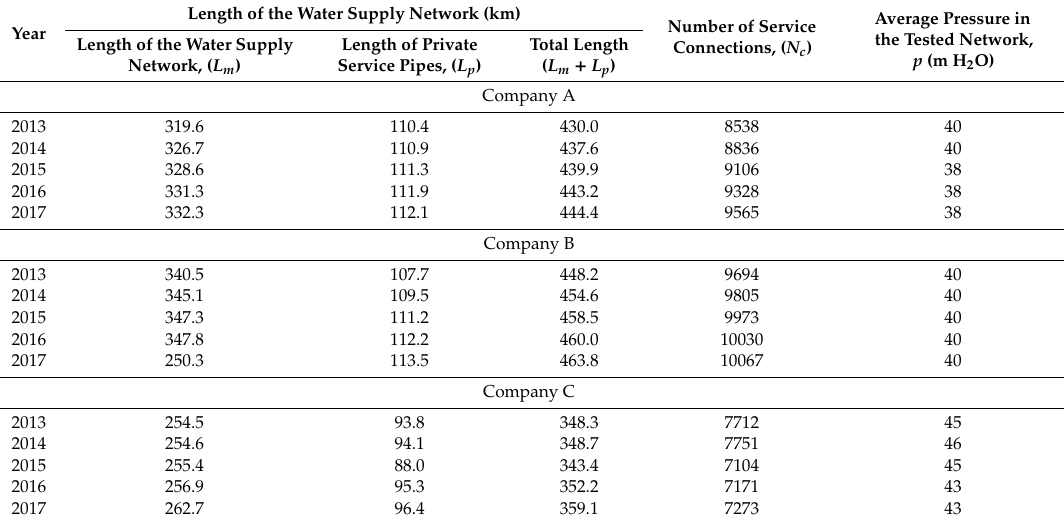
Table 1. Characteristics of the water supply